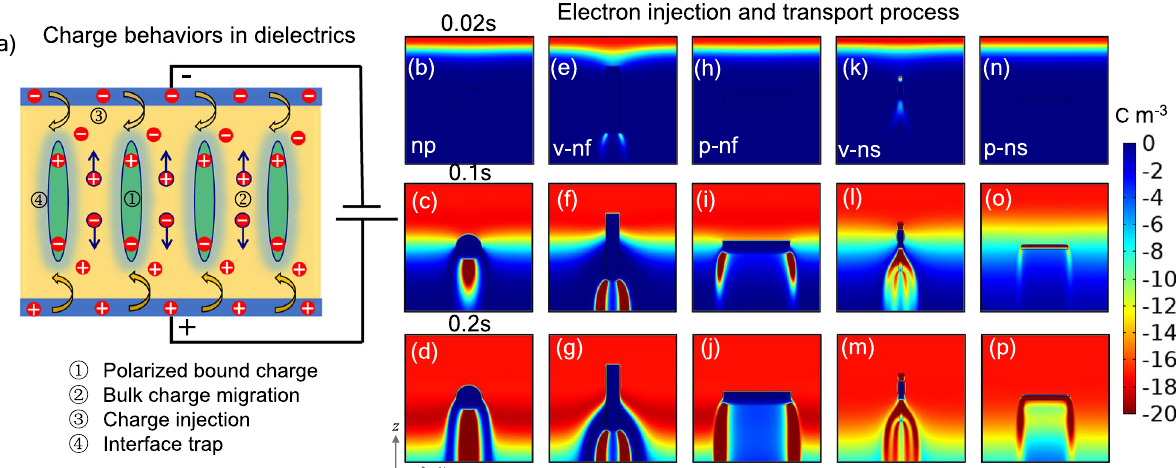
Fig. 2 The nano fi ller effect on the charge behaviors of polymer nanocomposites. a Schematic of four possible mechanisms in fl uencing charge behaviors in polymer nanocomposites with polymer matrix in yellow, nano fi llers in green, and electrodes in blue. The cross-sectional electron density of polymer nanocomposites with ( b – d ) one nanoparticle, ( e – g ) one vertical nano fi ber, ( h – j ) one parallel nano fi ber, ( k – m ) one vertical nanosheet, and ( n – p ) one parallel nanosheet, based on Schottky injection process with 0.02 s, 0.1 s, and 0.2 s. The applied electric fi eld is 500 MV m − 1 and the Schottky barrier is fi xed at 1.0 eV. The mobility in the polymer matrix and the nano fi llers are set at 1.0 × 10 − 11 and 0.1 cm 2 V − 1 s − 1 , respectively. The out-of-plane mobility of nanosheets is set to an ultralow value to re fl ect the anisotropy of charge